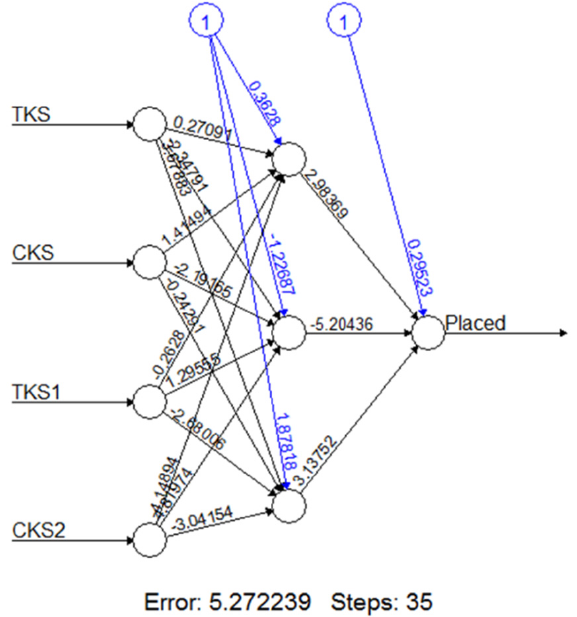
Figure A1. Example of estimating of shallow three-layer network with one hidden layer for the prediction of the market sentiment (stock returns, bond yields) from the first four moments of the error distribution. The input data for the network are pre-processed and the data for the first four monthly moments are being fed into the network. Blue arrows from circles marked as ‘1’ signify the training of one sample by the actual market index data.